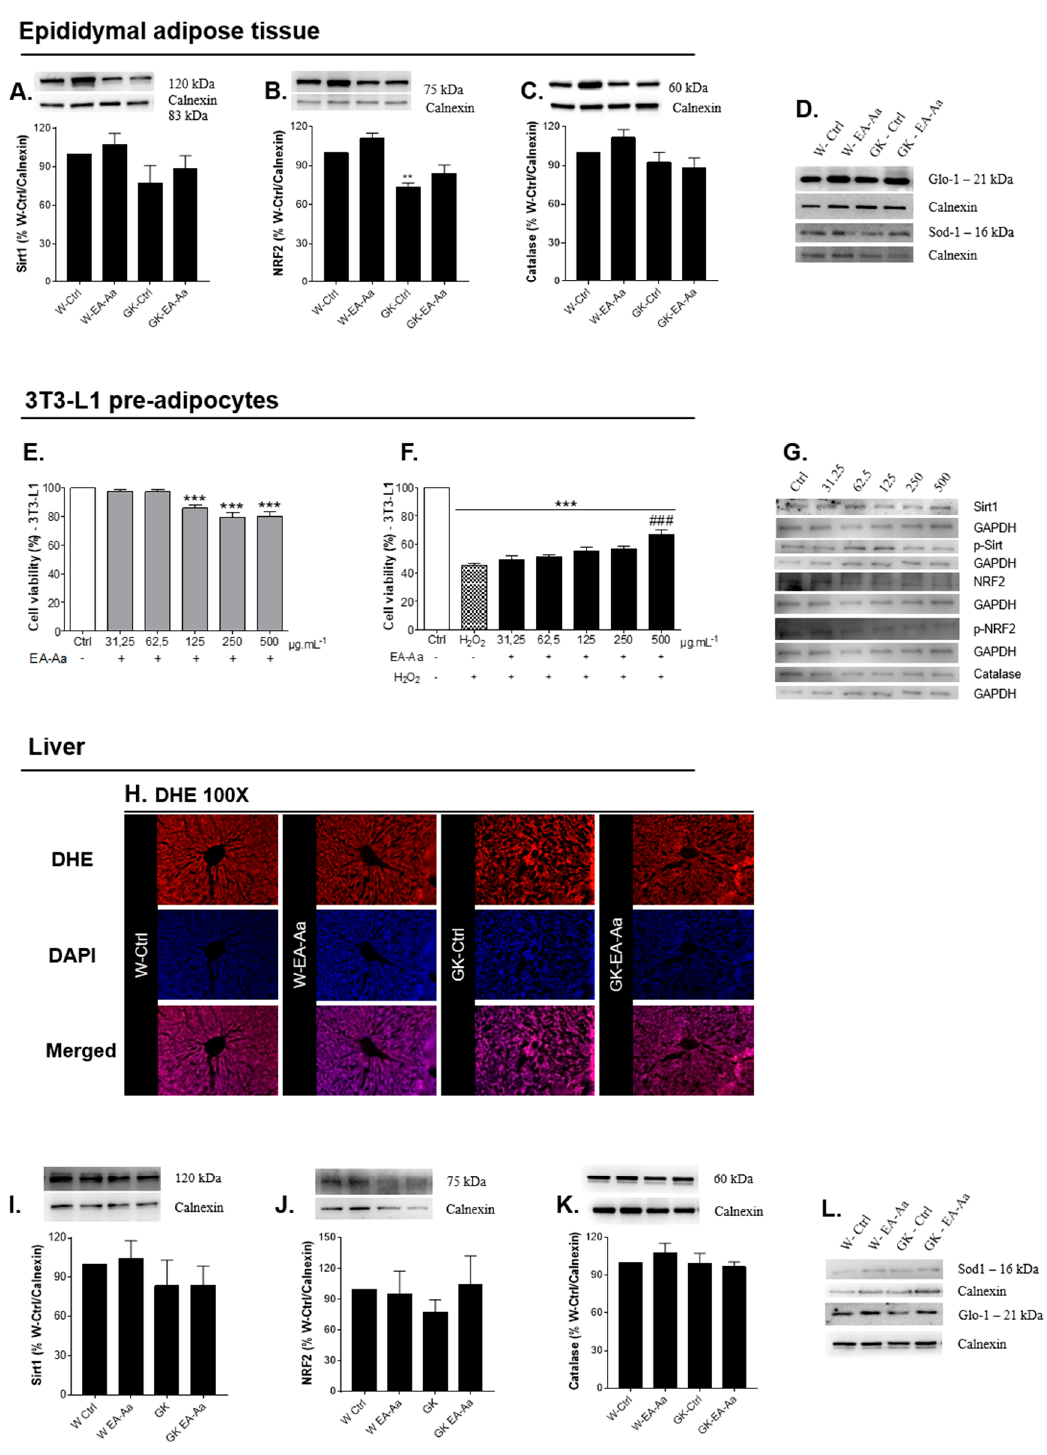
Figure 3. Antioxidant effects of EA-Aa in EAT, liver and in 3T3-L1 pre-adipocytes ( n = 3 independent experiments). ( A ) Sirt1 levels in EAT. ( B ) NRF2 levels in EAT, EA-Aa promotes partial restoration of NRF2 levels in the non-obese type 2 diabetic EA-Aa-treated group. ( C ) Catalase levels in EAT. ( D ) Representative images of EAT Western blot. Cell viability of pre-adipocytes 3T3-L1: ( E ) Treatment with EA-Aa for 24 h. ( F ) Treatment with EA-Aa (previously for 30 min) and induction to oxidative stress with H 2 O 2 (for 2 h). ( G ) Representative images of 3T3-L1 Western blot. ( H ) Dihydroethidium (DHE) staining in liver ( n = 3). ( I ) Sirt1 levels in liver. ( J ) NRF2 levels in liver. ( K ) Catalase levels in liver ( n = 5 for Western blots). ( L ) Representative images of liver Western blot. * vs. W-Ctrl/Ctrl; # vs. H 2 O 2 ; ** p < 0.01; ***,### p < 0.001.